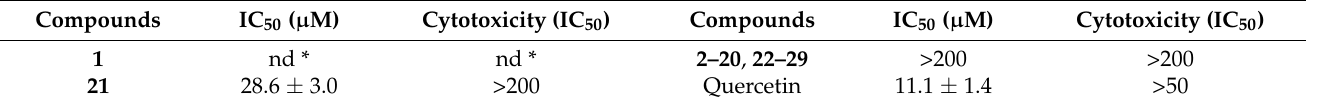
Table 4. NO inhibitory activities of compounds and positive control in RAW 264.7 cell